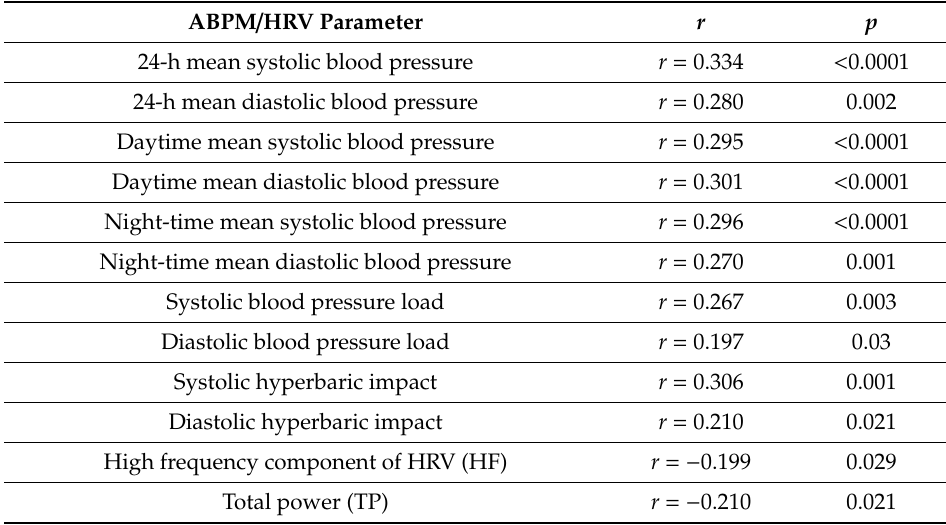
Table 4. Partial correlations between 24-h ambulatory blood pressure (ABPM) and heart rate variability (HRV) parameters and diastolic blood pressure response during sustained handgrip after adjustment for age, BMI and initial diastolic blood pressure values as confounders (multiple correlation analysis performed on variables of Table 4 being significant at level p <